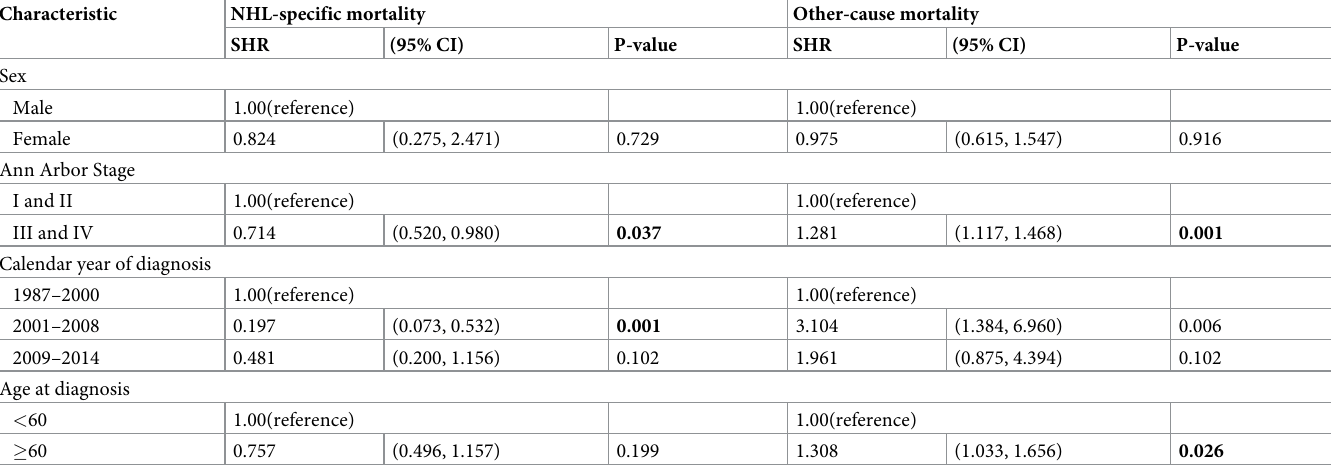
Table 5. Sub-hazard ratios of cause-specific death by sex, Ann Arbor Stage, calendar year of diagnosis and age at diagnosis by competing-risks regression.